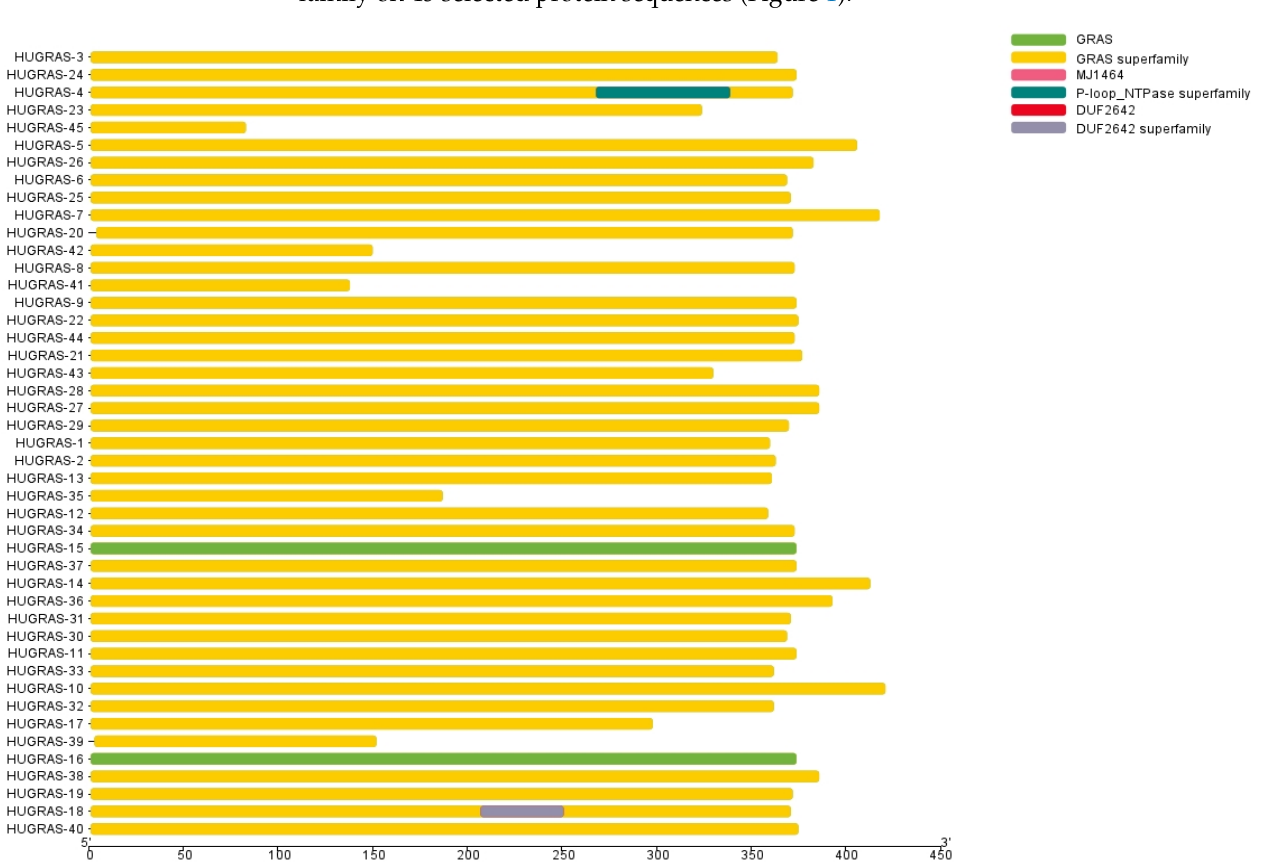
Figure 1. GRAS ‐ family protein domains. All 45 HuGRAS sequences ( HuGRAS ‐ 1 to HuGRAS ‐ 45) Figure 1. GRAS -family protein domains. All 45 HuGRAS sequences ( HuGRAS -1 to HuGRAS -45) contained GRAS domains. contained GRAS